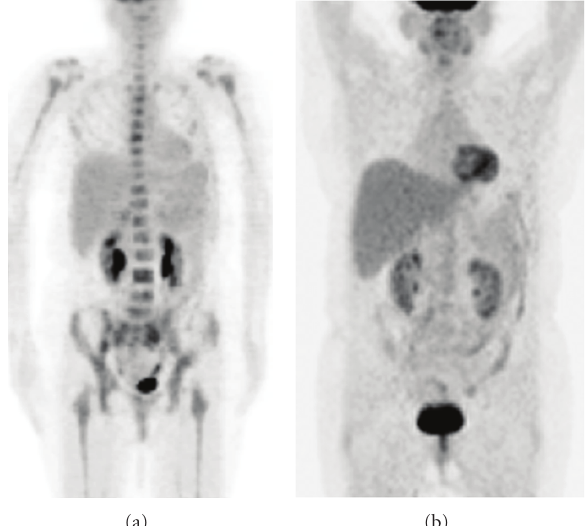
Figure 2: (a) An 18 F-fluorodeoxyglucose positron emission tomog- raphy (FDG-PET) scan showing disseminated bone marrow uptake at diagnosis. (b) FDG-PET scan after autologous stem cell trans- plantation showing the resolution of FDG